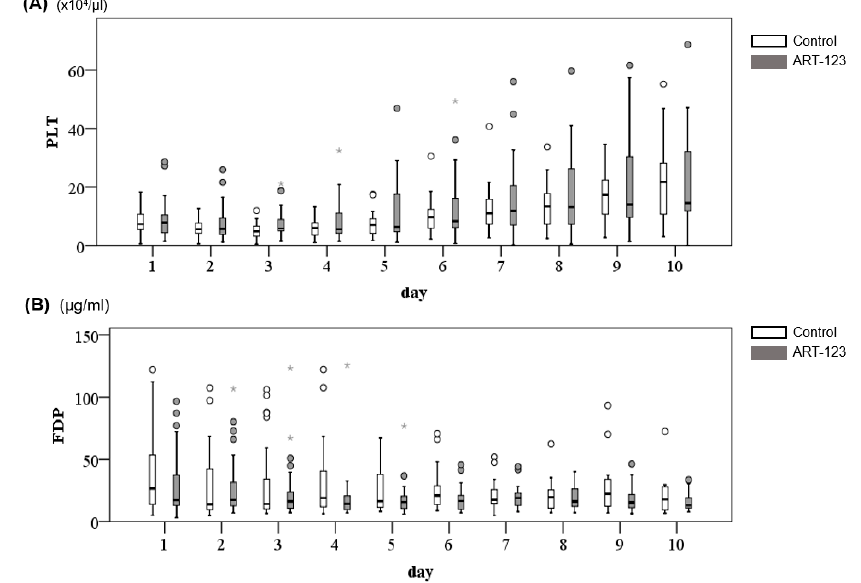
Figure 4. Changes of time course in platelets (PLT) ( A ) and fibrin/fibrinogen degradation products (FDP) ( B ).